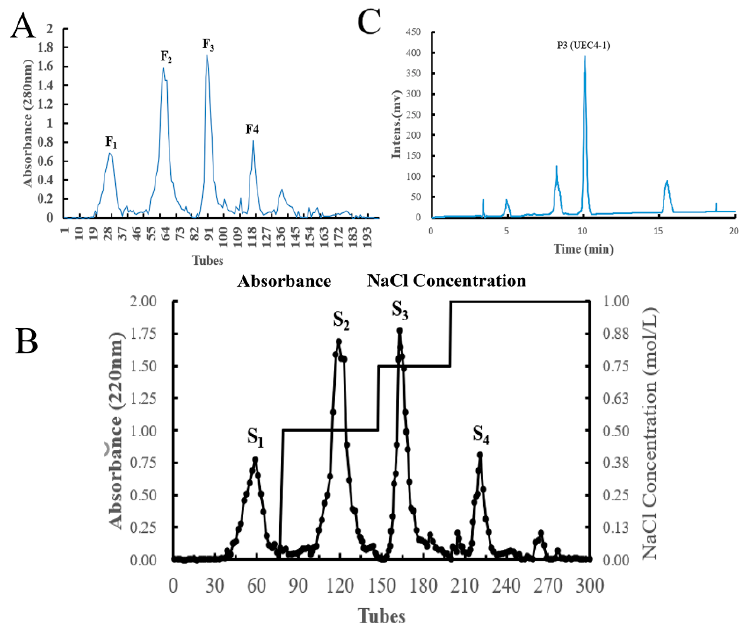
Figure 3. Separation and purification map of the fractions of enzymatic hydrolysis products from oyster. ( A ): Sephadex G-15 separation; ( B ): Superdex pre-packed column separation; ( C ): RP-HPLC analysis.